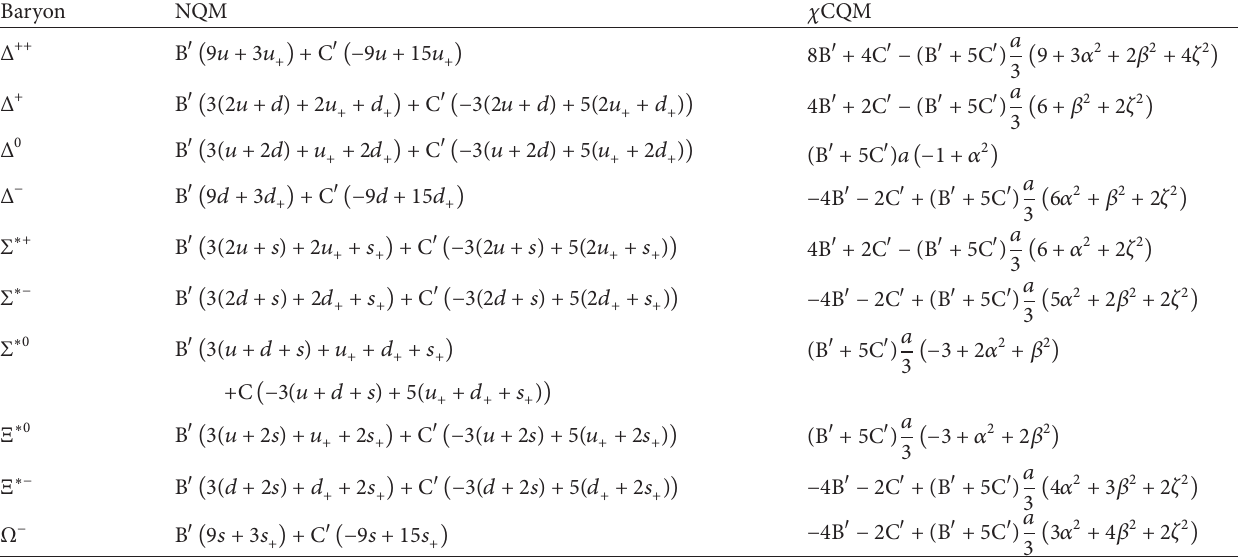
Table 8: Quadrupole moments of the decuplet baryons in NQM and 𝜒 CQM using the GPM.